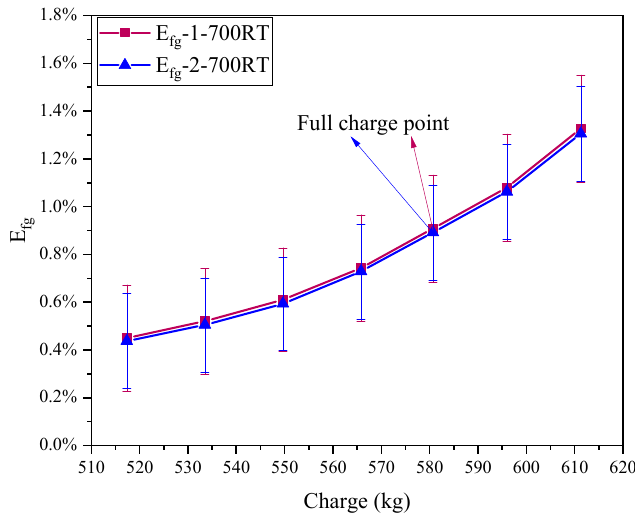
Figure 7. Liquid entrainment factor as a function of charge at 700 RT.